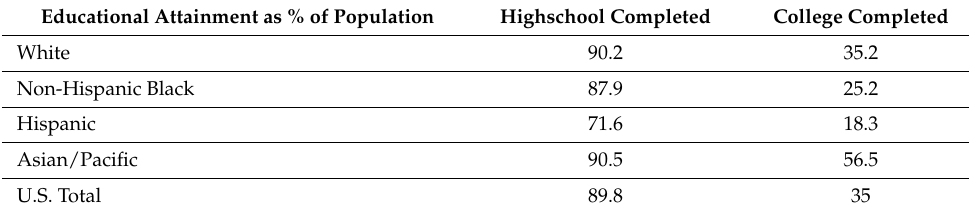
Table 3. Educational attainment in the U.S. by race and ethnicity [68].